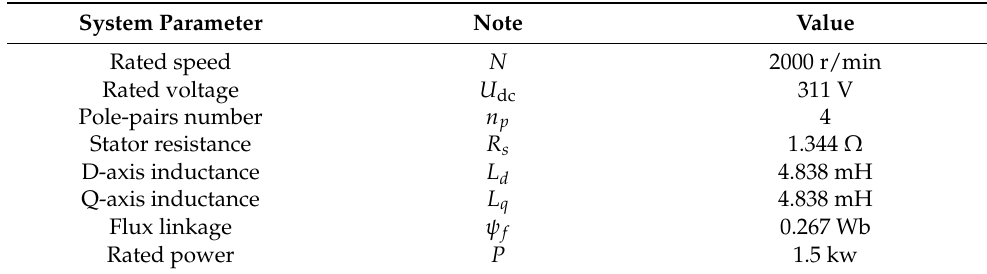
Figure 5. Experiment platform of PMSM. ( a ) controllers and the main circuits. ( b ) permanent magnet synchronous motor. Table 1. Experiment platform PMSM parameters.